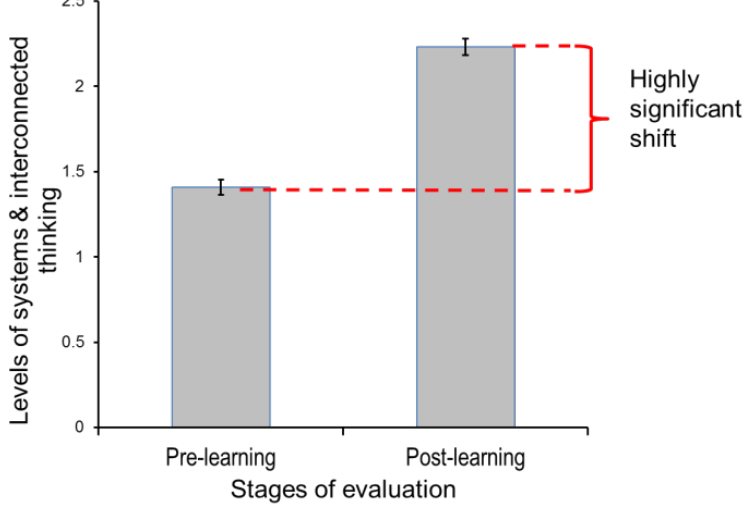
Figure 7. Average shifts of the students’ systems knowledge and perceptions after being involved in the Ecopolicy program. The vertical bars (I) represent the standard error (SE). Source: